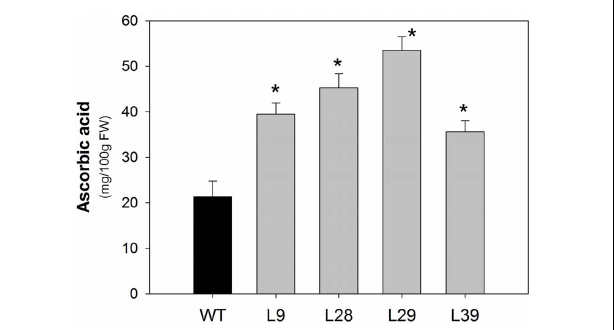
FIGURE 5 | Ascorbate of B33-PPi tomato lines. Ascorbic acid was determined in red tomato fruit (60 DAP). The values are presented as the mean ± SE of six biological replicates. An asterisk indicates the values that were determined by the t -test to be significantly different ( P < 0 . 05) from wild type.